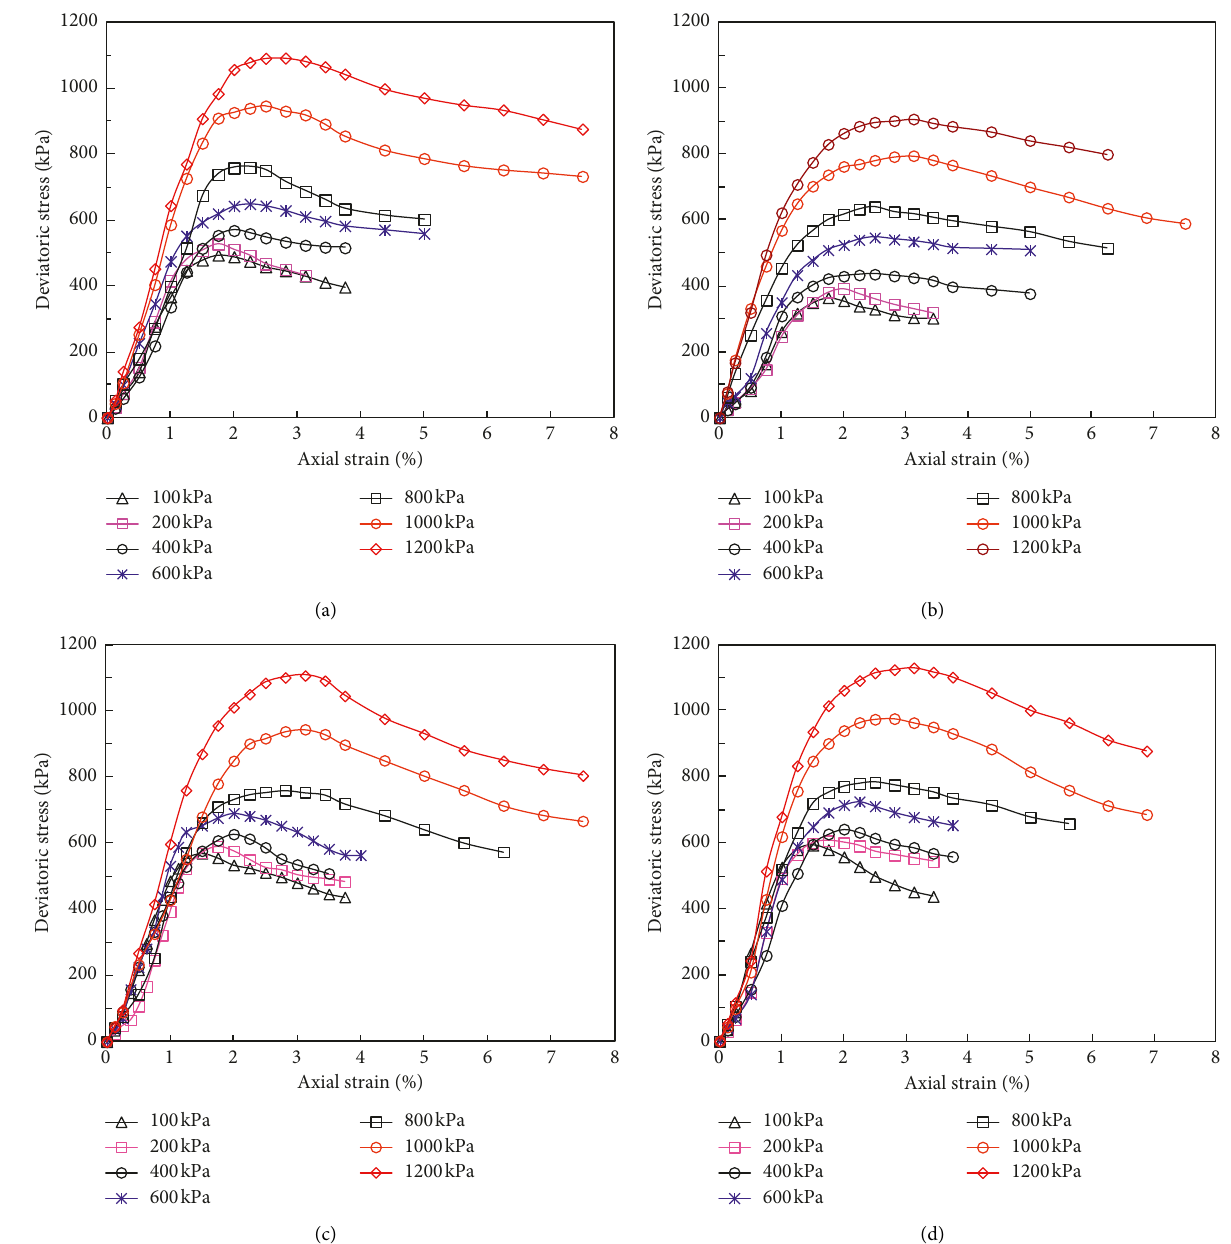
Figure 5: Relationship between deviatoric stress and axial strain at different applied confining pressures: (a) 2.5W+C100+P40, (b) 3.0W+ C100+P70, (c) 3.0W+C200, and (d)